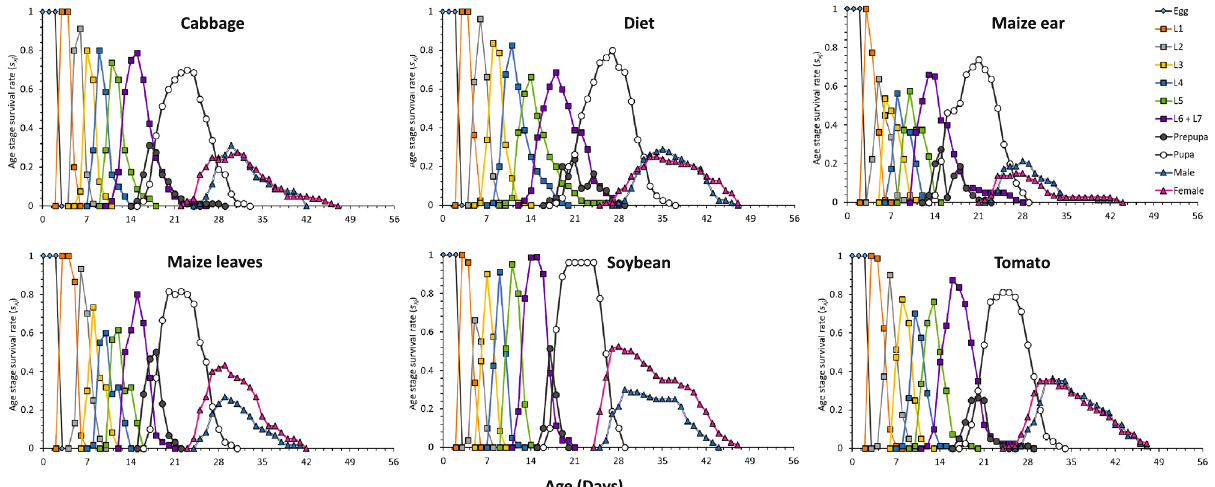
Figure 2. Age-stage-specific survival value (s xj ) of the fall armyworm, Spodoptera frugiperda fed on cabbage, maize ear, maize leaves, artificial diet, soybean, and Pre-adult stage duration was significantly shorter in maize ear, compared to artificial diet treatment, and fol- lowed by other vegetable treatments with intermediate length in the pre-adult stage duration (Table 2, Fig. 2). The highest percentage of survival was observed in soybean-reared insects (85%), followed by maize leaves (80%), tomato (77.5%), cabbage (66%), artificial diet (58.7%), and maize ear (57.5%) (Table 2). In line with this, the highest percentage of resulting females were observed in soybean (62% of pre-adults), followed by maize leaves (58%), tomato (48%), artificial diet (45%), maize ear (43%), and cabbage (38%) (Table 2, Fig. 2). In addition to the duration of the different FAW stages, the effect of treatments was also assessed on the pre-pupal weight (Fig. 3). Female pupae reared on artificial diet treatment were significantly heavier than pupae reared on cabbage, maize leaves, and tomato (Fig. 3), whereas male pupae reared on maize ear and diet were significantly heavier than pupae reared on cabbage and tomato (Fig. 3). Not all females were reproductively active, and this was observed among all treatments. Therefore, the pre- oviposition period (APOP), total pre-oviposition period (TPOP), oviposition period, and fecundity parameters were calculated based on the information gathered from the reproductive females and not for the total number of females recorded (Table 3). Moreover, for cabbage, only 11 (44%) out of the 25 initially recorded females pro- duced eggs, whereas in the case of maize ear, maize leaves, artificial diet, soybean, and tomato, the reproductive females were 25, 68, 29, 55, and 60% out of the total amount of females recorded for each treatment, respectively (Table 3). Feeding on different host plants also affected other parameters, including adult APOP, TPOP, oviposition period, and fecundity of the Fall armyworm (Table 3, Fig. 4). Females had the shortest APOP (i.e., number of days before a female start laying eggs and counted from adult emergence) in cabbage, artificial diet, maize ear, and tomato (2.5–2.6 days), whereas females reared in maize leaves started laying their eggs 5 days after emergence. In line with this, the TPOP (i.e., number of days that includes the pre-adult stage + APOP) was 4 days shorter in females fed on cabbage, maize ear, and soybean, compared to females reared on maize leaves (Table 3, Fig. 4). FAW females reared on soybean and cabbage had the longest oviposition period (i.e., the number of days that female produced offspring), almost double compared to maize treatments. In addition, females reared on cab- bage, soybean, tomato, and maize ear laid 2.4–4.5 times more viable eggs compared to females reared on maize leaves and diet treatments (Table 3, Fig. 4). The age ‐ specific survival rate ( l x ), fecundity ( m x ), and maternity ( l x m x ) values of the FAW reared on six differ- ent treatments are plotted in Fig. 4. Highest peaks on fecundity were observed for females fed and ovipositing on cabbage, soybean, tomato, followed by artificial diet and maize with the lowest fecundity values. Maternity curves ( l x m x ) had a higher peak on soybean, tomato, and cabbage, followed by lower curves in maize and artificial diet treatments. In addition, information on cumulative fecundity including all reproductive females in each treat- ment showed a higher total contribution of viable eggs (i.e. larvae) in soybean, cabbage and tomato treatments, compared to maize treatments (Table 3, Fig. 5). Net reproductive rate ( R 0 ) was 5.7 and 11.4 times bigger in soybean compared to maize ear and artificial diet, respectively (Table 4). The intrinsic rate of increase ( r ) and finite rate of increase ( λ ) of FAW were higher on soybean, tomato, and cabbage compared to maize (intermediate), and artificial diet (lowest), which suggest FAW populations will grow faster in the vegetable crops tested compared to the artificial diet. In contrast, a shorter mean generation time was observed in females from the maize treatment compared to the other vegetable crops tested.